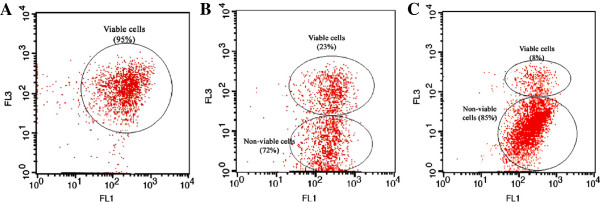
Flow-cytometric analysis of cellular dehydrogenases of freeze-dried A. senegalensis cells stored at −21°C (A), 4°C (B) and 35°C (C) for 12 months. Thiazole orange (TO) was used to stain all the cells (viable and non-viable cells). CTC is reduced by active cellular dehydrogenases, and the emitted light is absorbed on FL3. The activity of dehydrogenases which determined by CTC reduction was considered as a sign of viability.